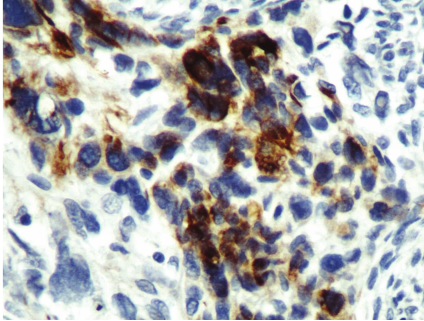
Figure 15: Brain metastasis, Desmin cytoplasmic staining: ×